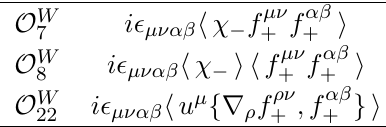
Table 1 . Relevant non-resonant odd-intrinsic parity